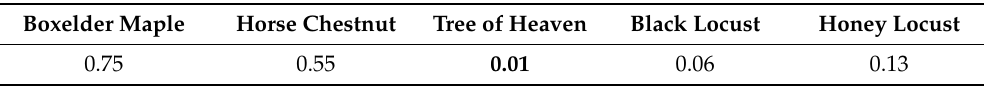
Table 5. Statistical difference of the routing surface quality grades between different tree species expressed by the p -value of the ANOVA analysis. The values in bold indicate a significant difference. Horse Chestnut